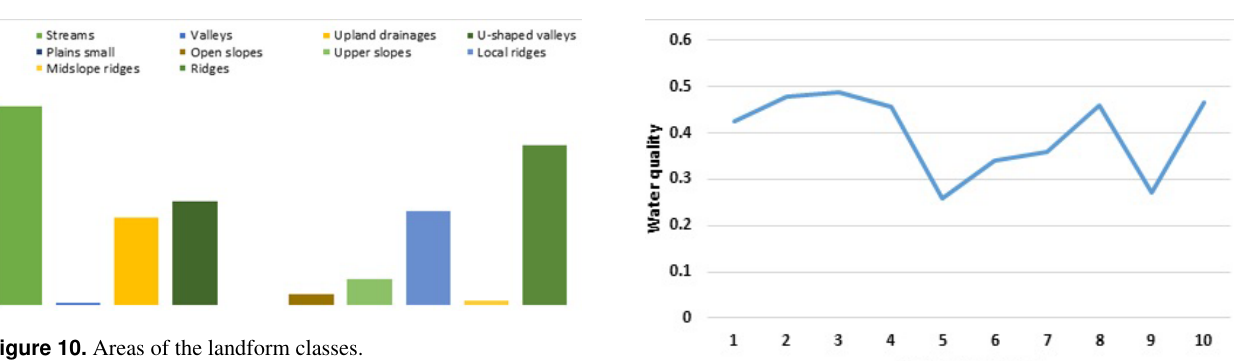
Figure 10. Areas of the landform classes.